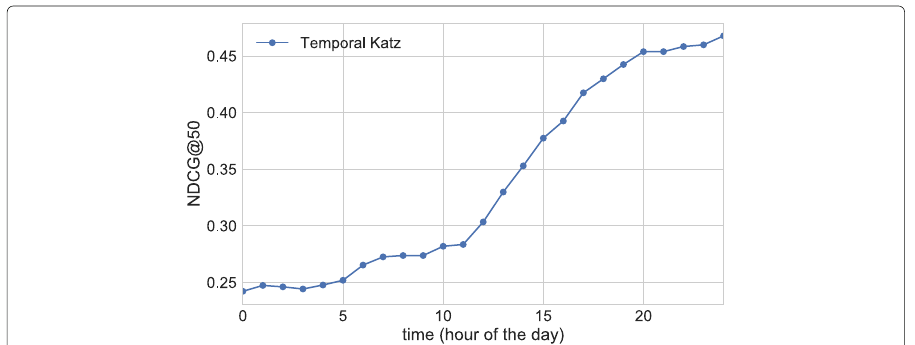
Fig. 10 Average daily NDCG@50 performance of temporal Katz centrality on the UO17 data